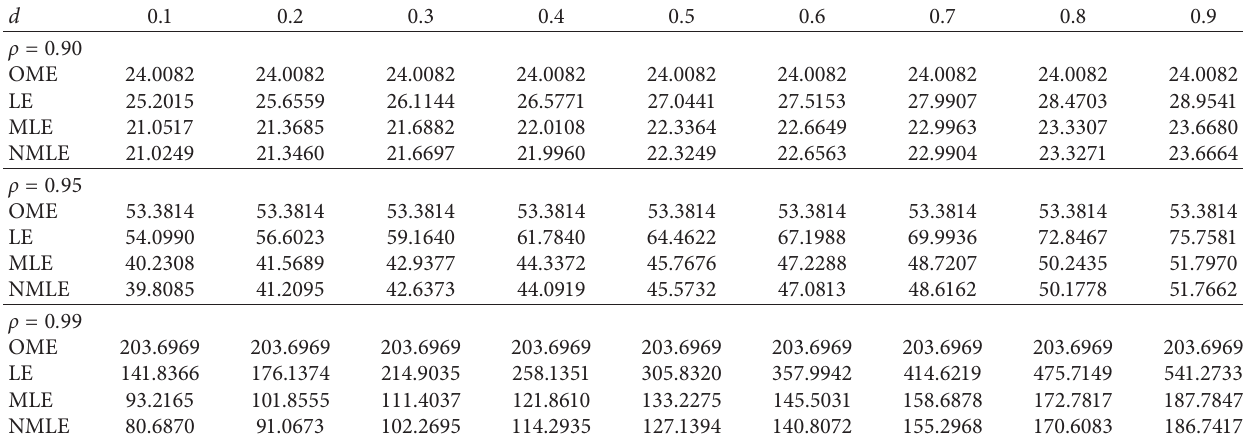
Table 5: MSE values of the estimator for different values of d and ρ when σ � 10 and n �